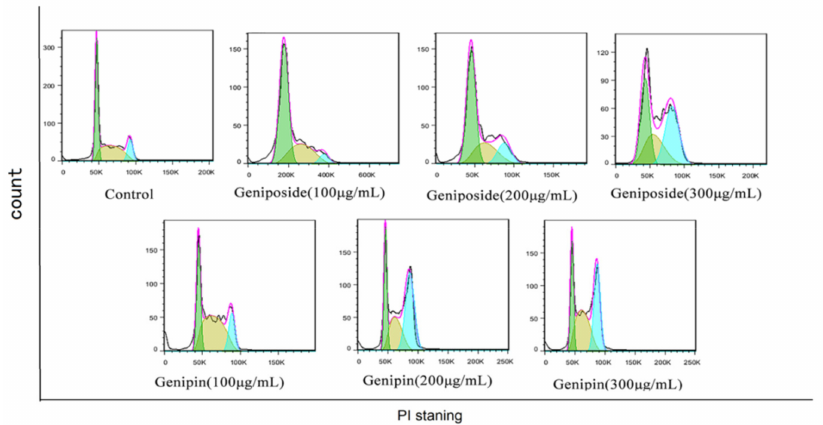
Figure 5. Geniposide and genipin on the BRL-3A cell cycle.